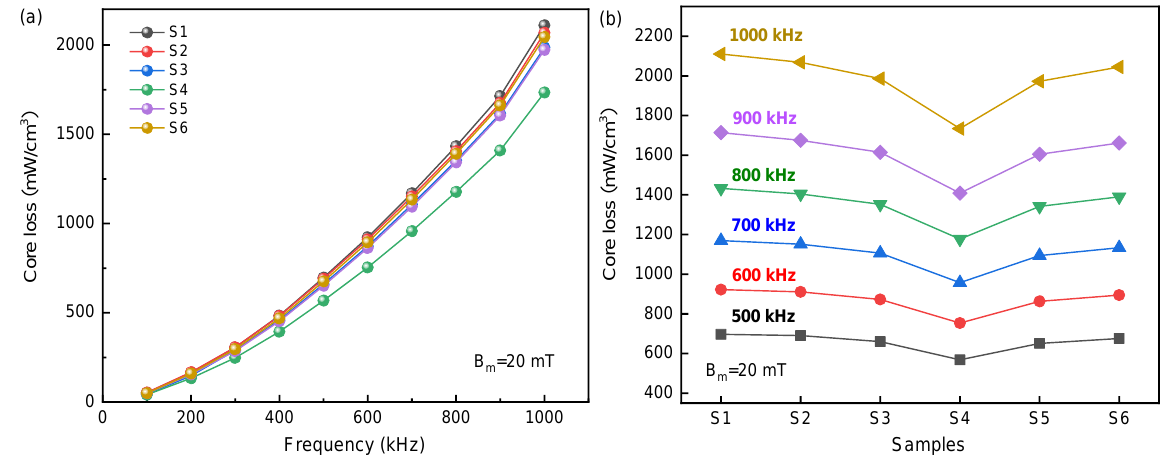
Figure 8. The total core losses of SMPCs for S1~S6:( a ) under different EP content; ( b ) in the range of 500~1000 kHz.